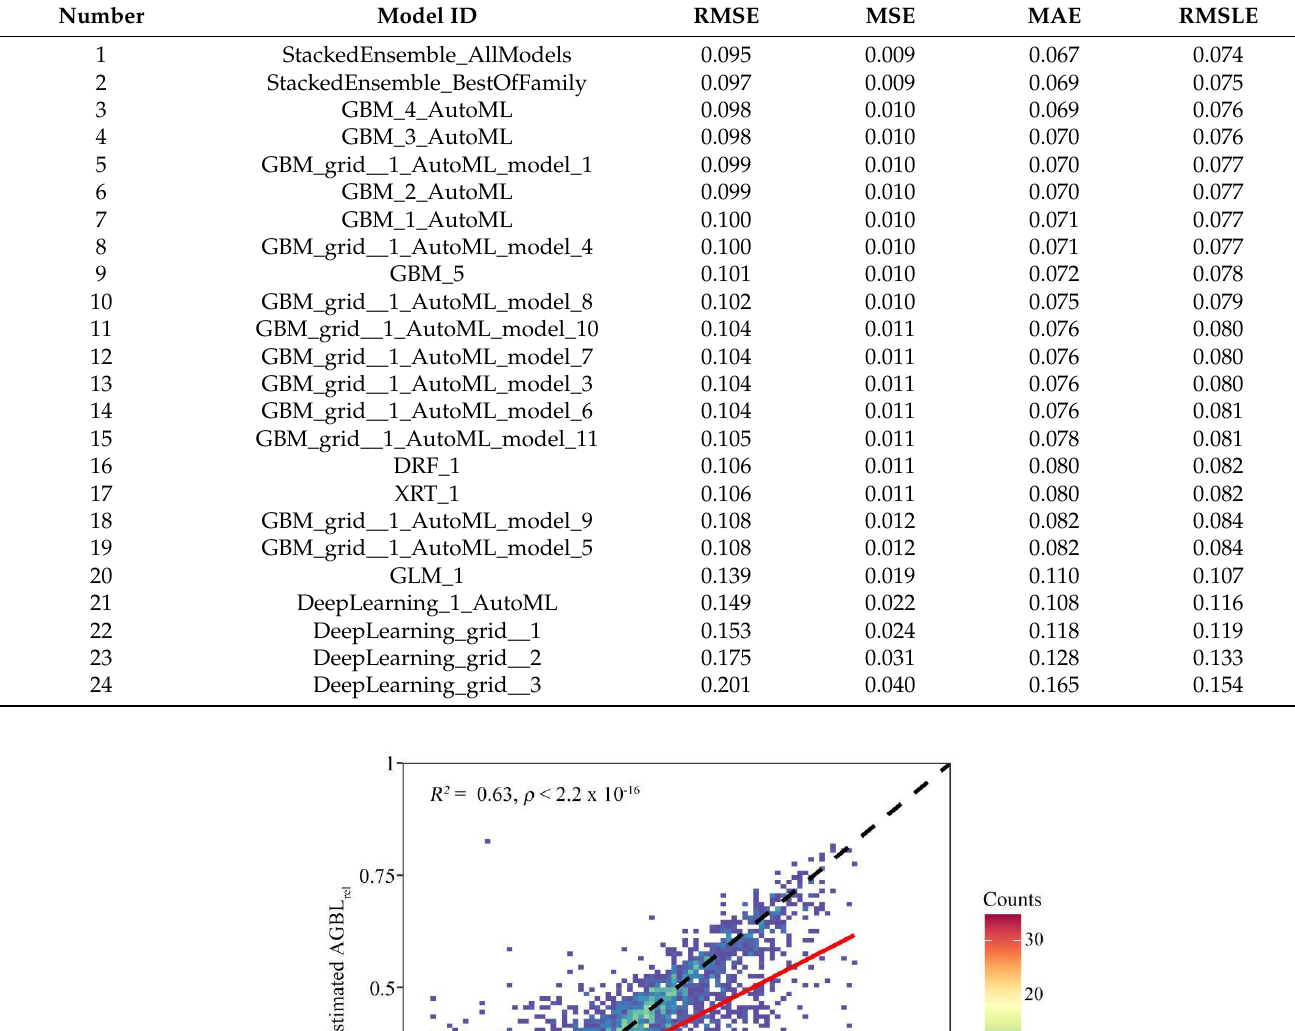
Table 2. The statistical error results of the vulnerability models of PBLrel and AGBrel in the training set (root mean squared error (RMSE), mean square error (MSE), mean absolute error (MAE) and root mean squared logarithmic error (RMSLE)).